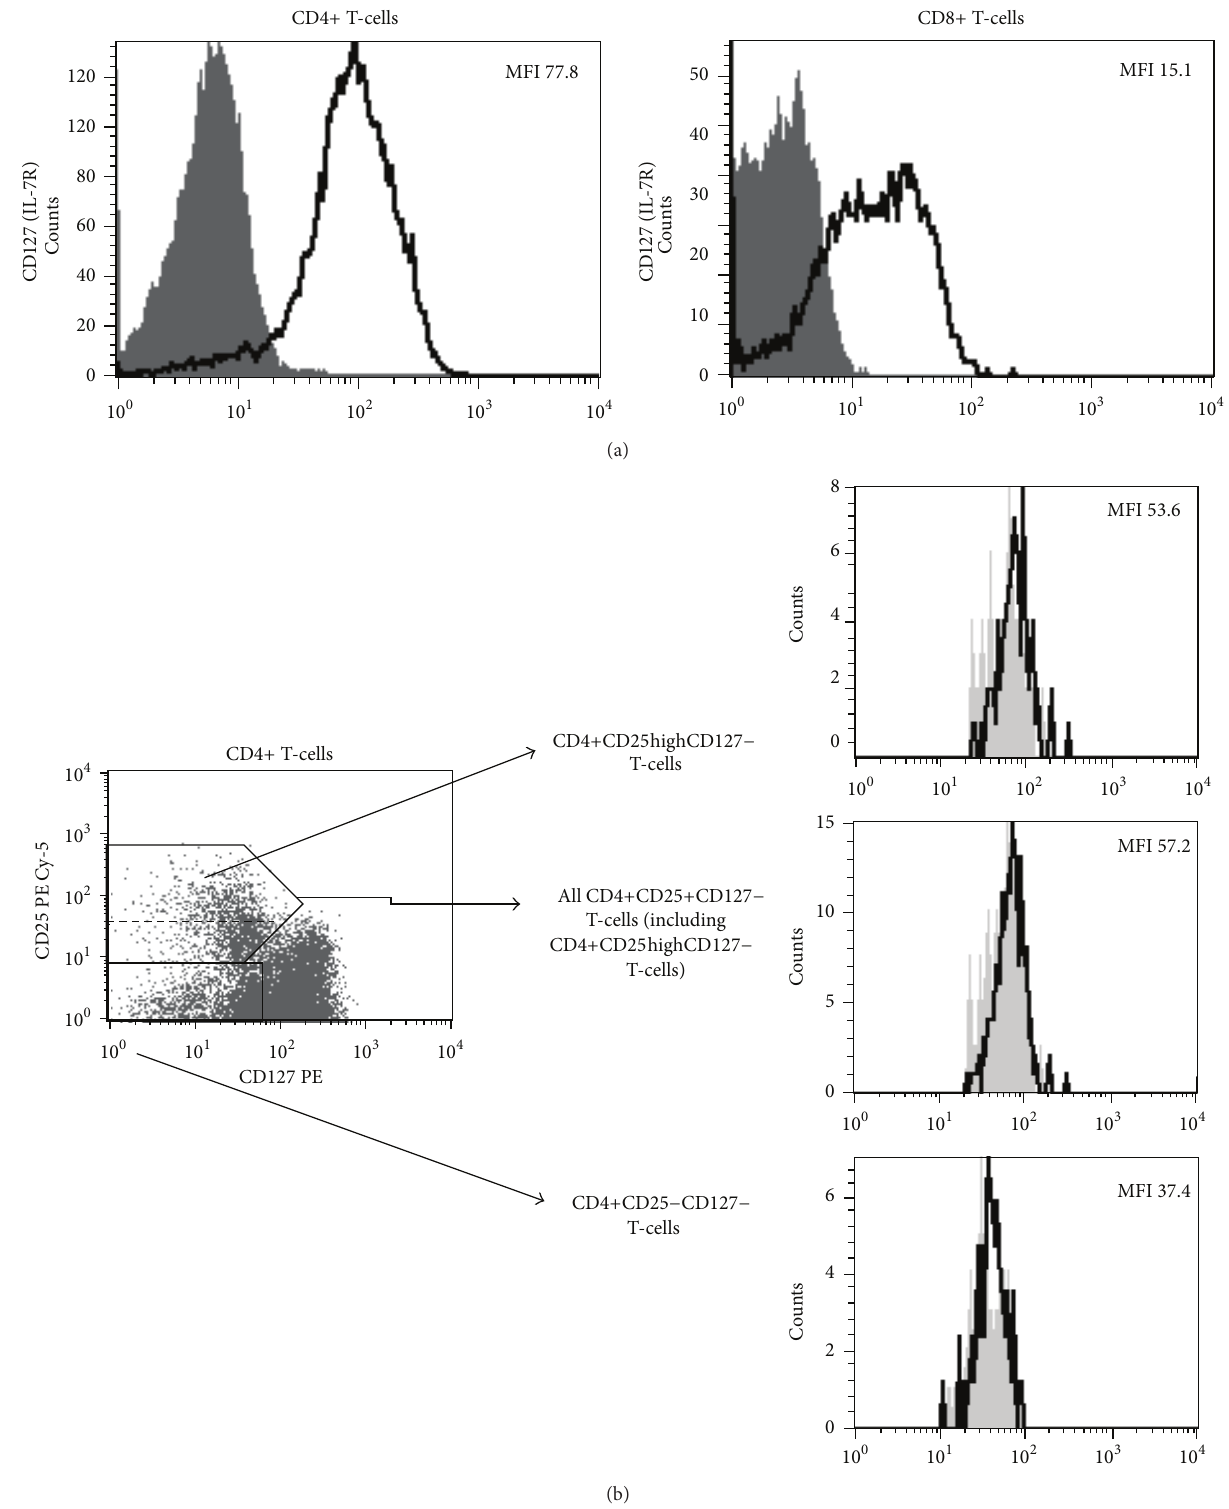
Figure 1: Representative histograms and plots characteristic for studied individuals. (a) Flow cytometric analysis of mean fluorescence intensity of CD127 expression on CD4+ and CD8+ T-cells. Thick black lines represent staining with anti-CD127 monoclonal antibody, grey areas represent fluorescence-minus-one controls. (b) Left panel: dot plot demonstrates staining method used for delineation of CD4+CD25+CD127 − T-cells (upper black box) and CD4+CD25-CD127 − T-cells (bottom black box). Dashed line within upper black box delineates CD4+CD25highCD127 T-cells within all CD4+CD25+CD127 − T-cells. Right panel: histograms representing FoxP3 expression within different T-cell subsets (black lines). Grey areas represent isotype controls. Values are for mean fluorescence intensity (MFI) of FoxP3 expression within different T-cells